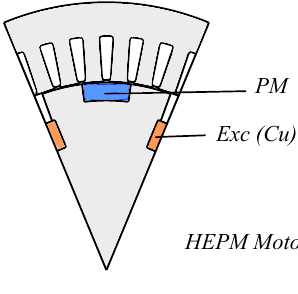
Figure 5. IPM and HEPM configuration.